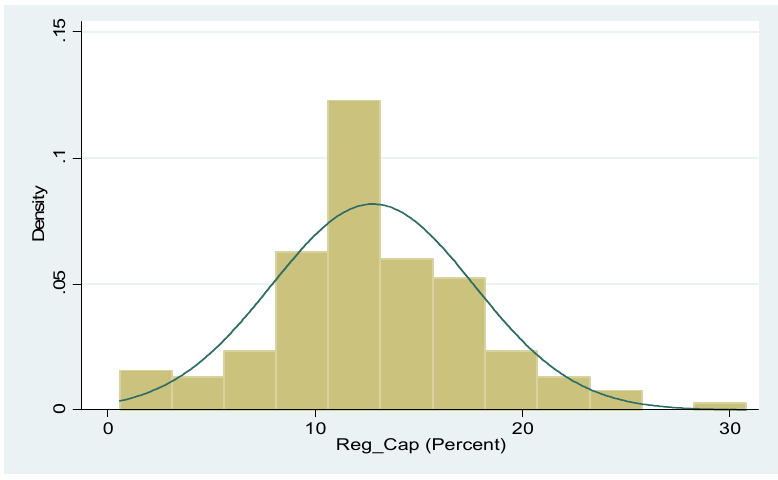
Figure 2. Distribution of Reg_Cap variable.